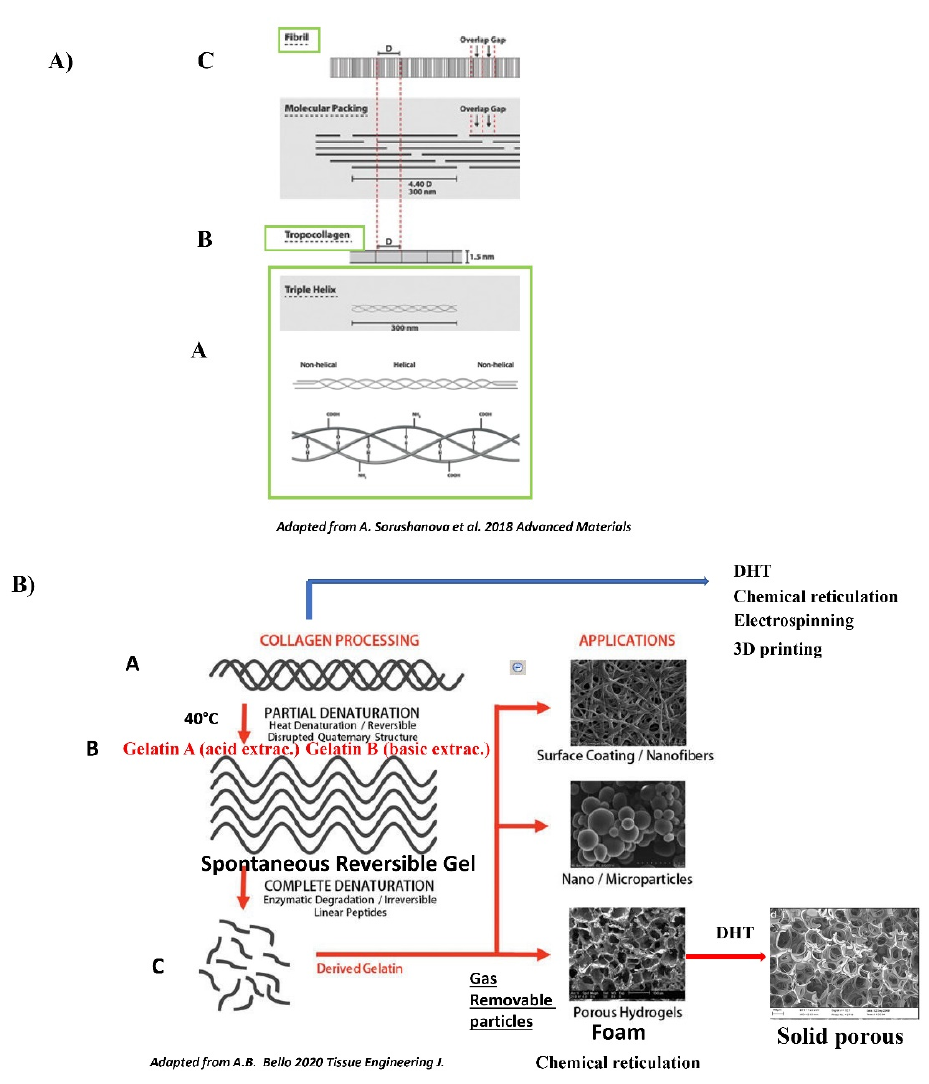
Figure 1. Collagen and gelatin-based polymers. ( A ) Collagen structure and organization. The collagen primary structure contains the RGD sequence, but is inside the triple helix and therefore not functional. Panel A: The collagen monomer is organized in two helical regions and two non-helical regions. The collagen triple helix (tertiary structure) has a coiled-coil structure made of three parallel polypeptide α chains (secondary structure). Panel B: The collagen monomers will spontaneously self-assemble end to end to form tropocollagen and also laterally to form a larger structure, such as fibrils. Panel C: Schematic representation of the arrangement of collagen molecules within fibrils ( adapted from A. Sorushanova et al. Adv. Mater. 2018 [16]). ( B ) Due to its triple helix and spontaneous propensity to self-assemble into more complex